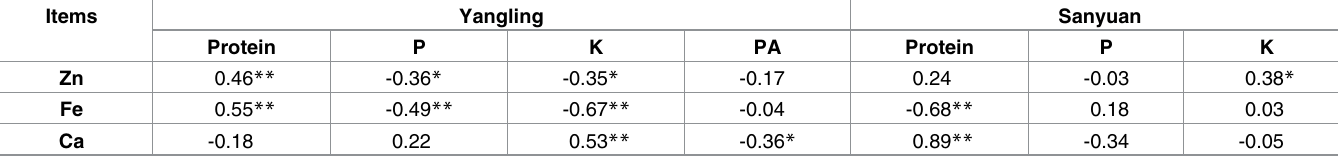
Table 6. Correlation coefficients between nutrients concentrations in grain of winter wheat grown at different soil N fertilizer rates and foliar fertil- izer applications at Yangling during 2010–2014and Sanyuan during 2012–2014.